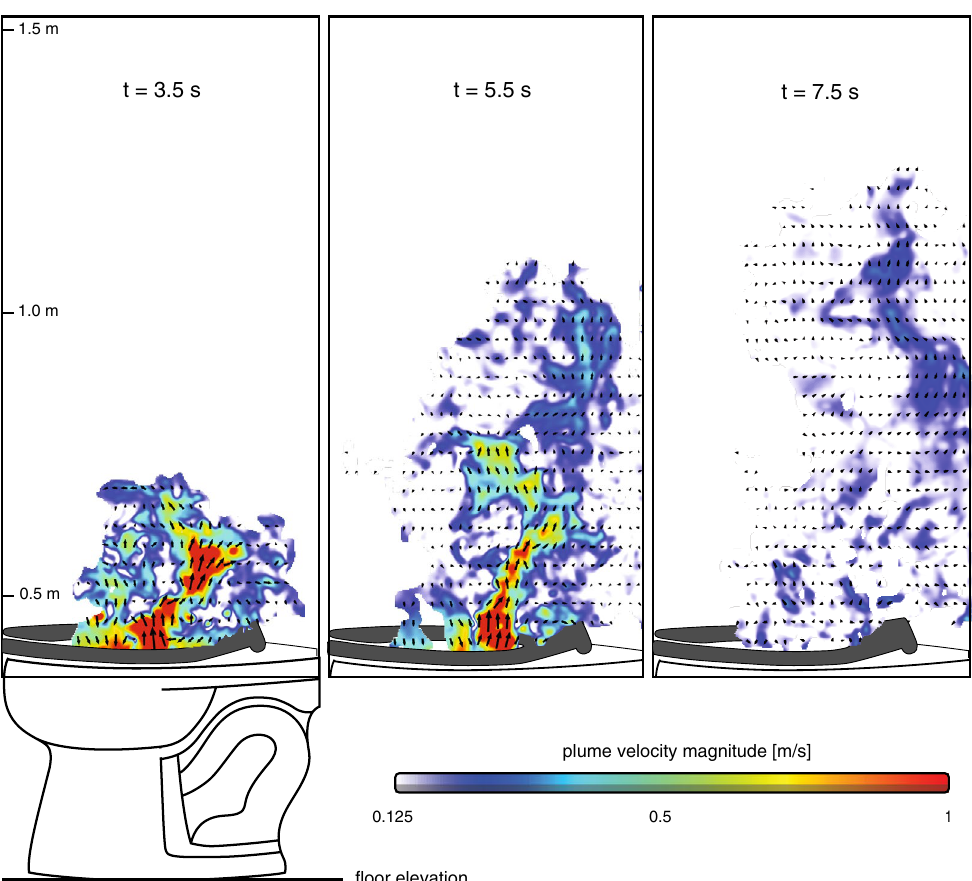
Figure 4. Turbulent flowfields responsible for aerosol plume transport. Time sequence of flush-induced instantaneous velocities computed from particle image pairs using PIV for the same flush sequence shown in Fig. 3. Flow direction is indicated within the plume envelopes by black arrows, and velocity magnitude is indicated by arrow length and also by the colormap. The turbulent velocity fields exhibit high velocity jet-like structures (red) that oscillate rapidly during the flush. The velocity magnitude colormap starts at 0.125 m/s which is typical of ambient flow velocities in the laboratory where the measurements were